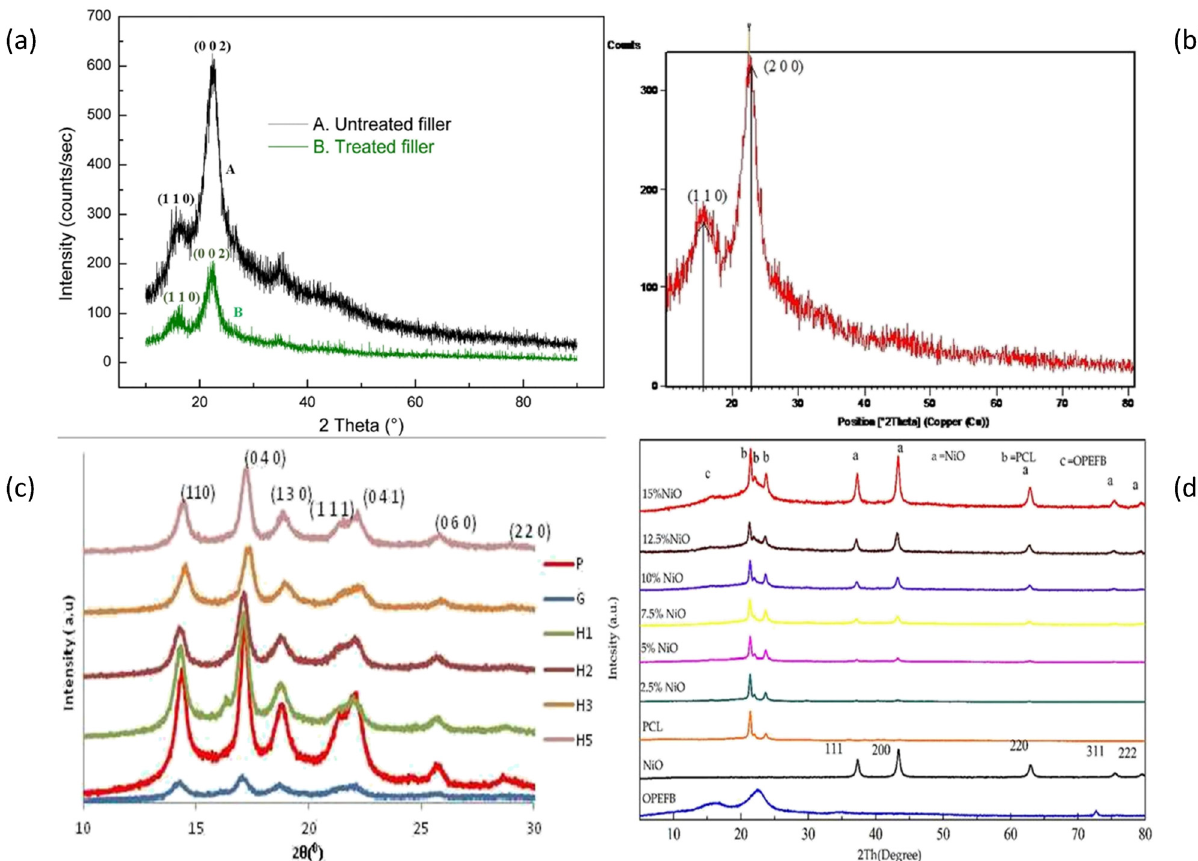
Figure 1: XRD peaks of fi ller materials ( 86 – 89 ) . Copyright © 2019, Springer Nature; Copyright © 2019, 2020, Elsevier; Copyright © 2018, John Wiley and